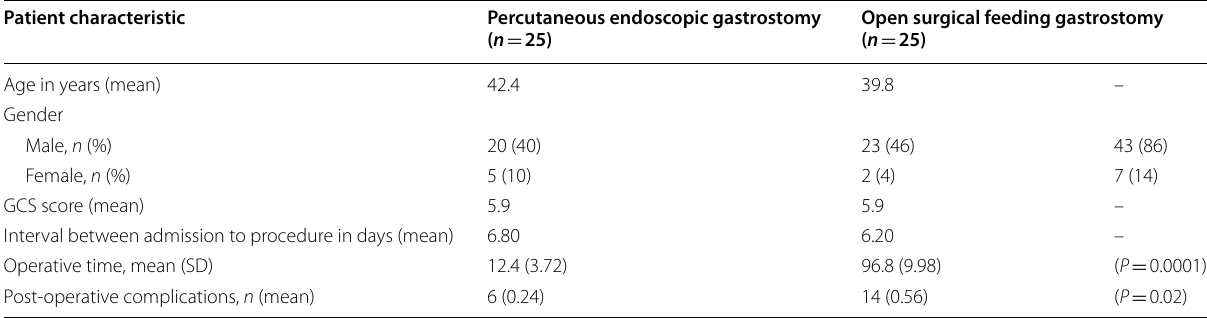
GCS Glasgow coma